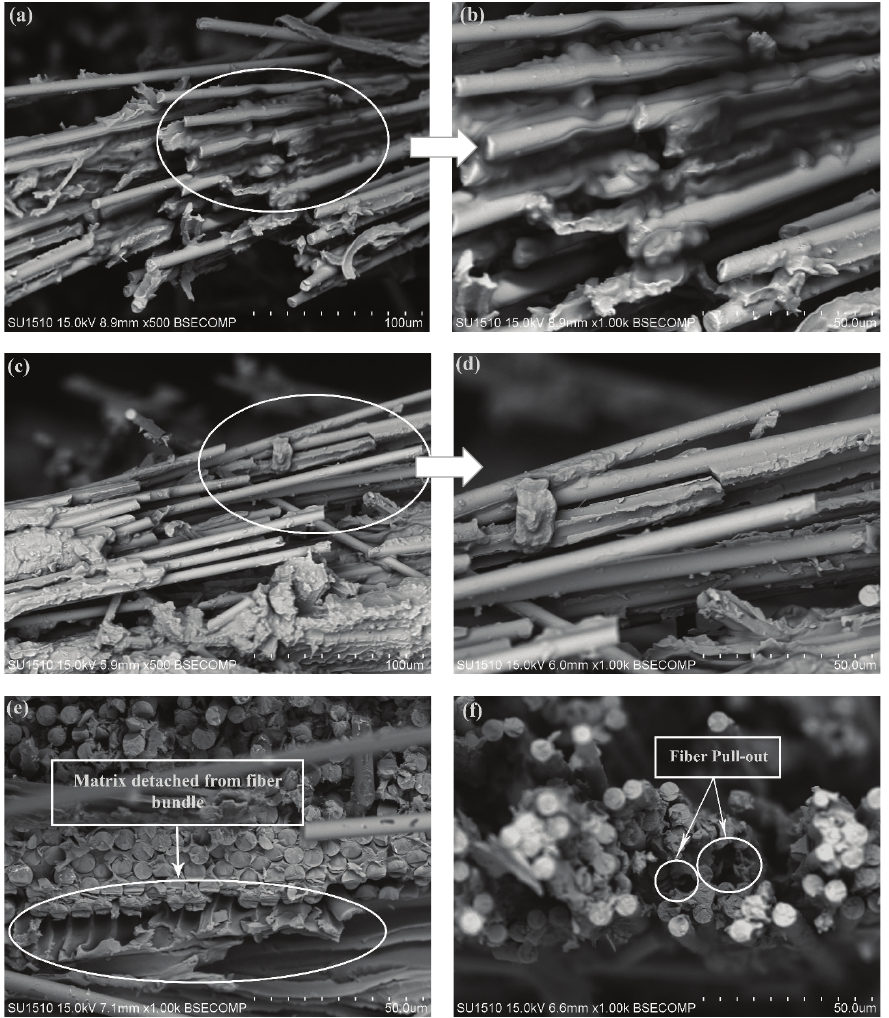
Figure 16: SEM observation on the cryofractured surface of EHG250-68-37 composite specimens; (a) fiber-matrix adhesion of unaged sample; (b) zoom on fiber-matrix adhesion corresponding to (a); (c) fiber-matrix adhesion of aged sample; (d) zoom on fiber-matrix adhesion corresponding to (c); (e) matrix detached from fiber bundle of aged sample; (f) fiber pullout of aged